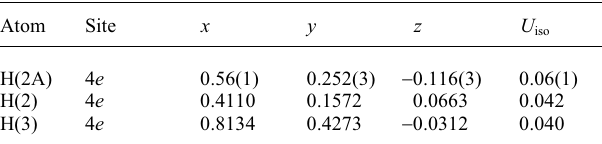
Table 2. Atomic coordinates and displacement parameters (in Å 2 )